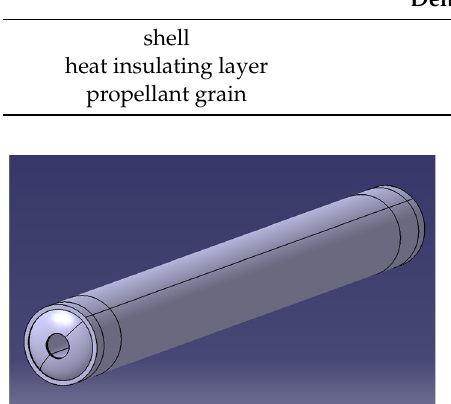
Figure 7. Structure of the solid rocket engine model.